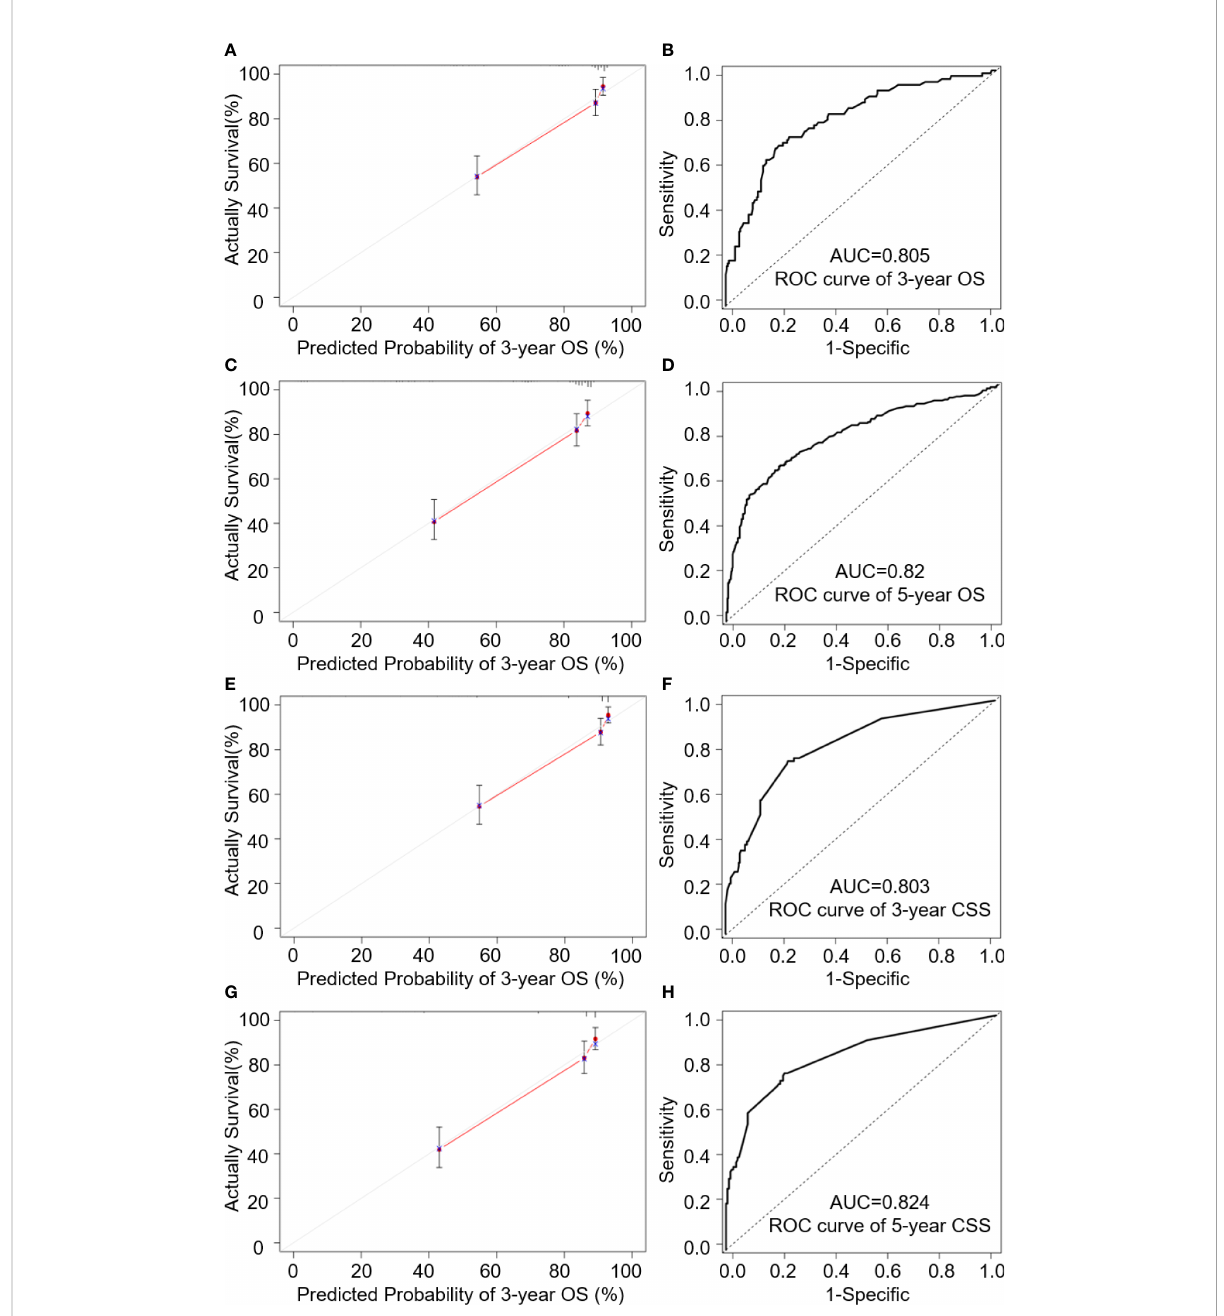
FIGURE 4 Internal validation cohort analysis of; (A, C) 3- and 5-year calibration curves of OS predictions; (B, D) 3- and 5-year ROC analysis of age, T stage, M stage and LODDS for OS; (E, G) 3- and 5-year calibration curves of CSS predictions; (F, H) ROC analysis of age, T stage, M stage, Seer stage and LNR for